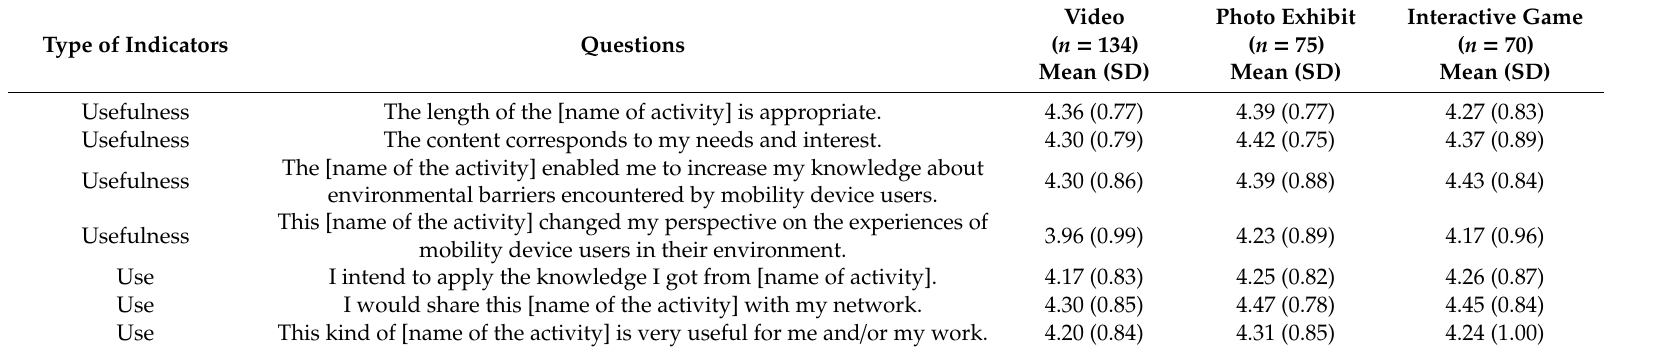
Table 3. Questionnaire Evaluation of the Usefulness and Use of KM Strategies.